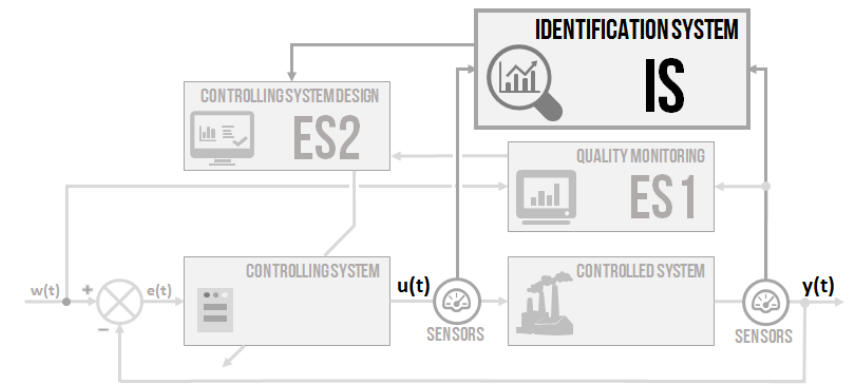
Figure 8. The schema of the concept of intelligent controlling system with outlined block of the controlled system identification